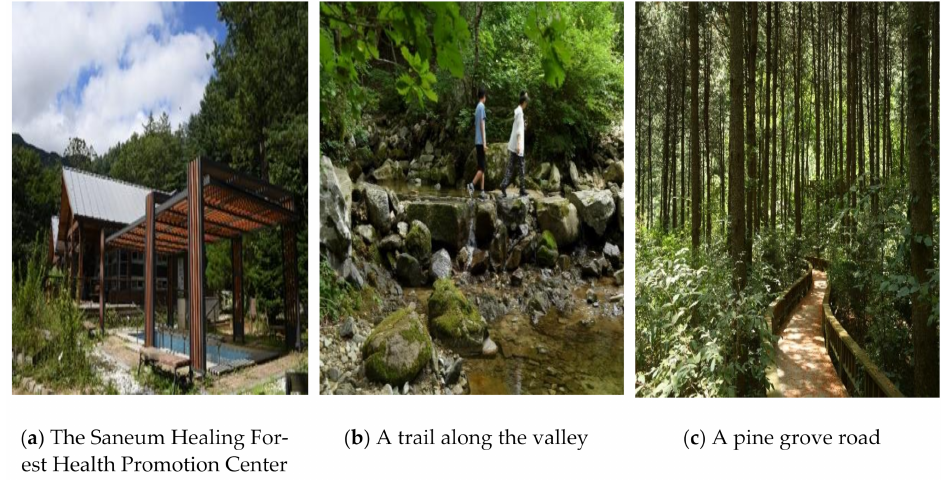
Figure 1. The Saneum Healing